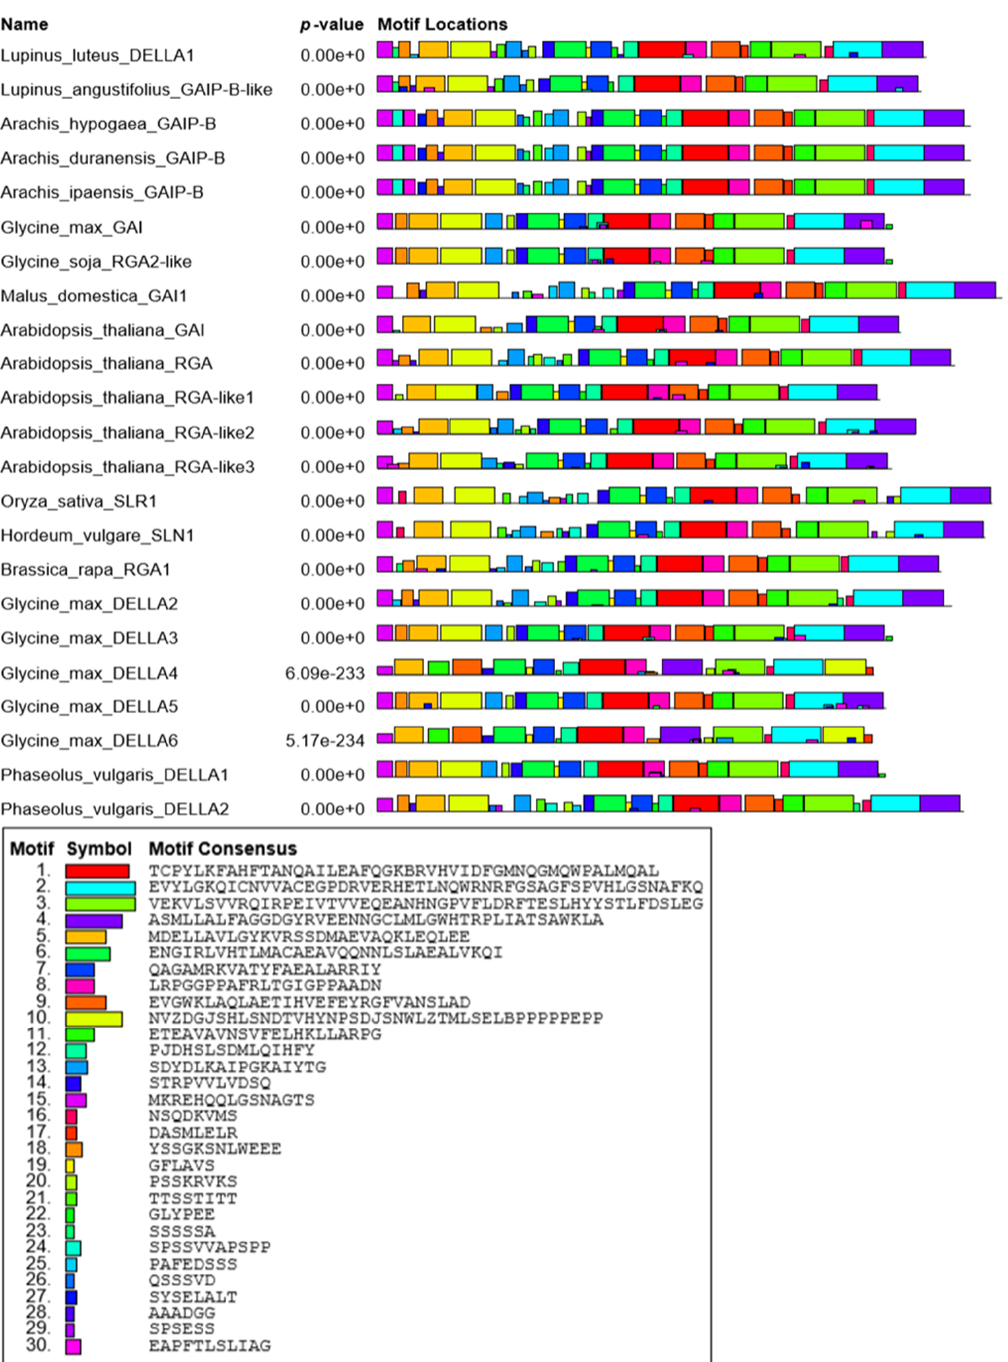
Figure 2. This diagram shows the location of motif sites in 23 DELLAs from different plant species. Each block shows the position and strength of a motif site. The height of a block gives an indication of the significance of the site, as taller blocks are more significant. The height is calculated to be proportional to the negative logarithm of the p -value of the site, truncated at the height for a p -value of 1 × 10 -10 .